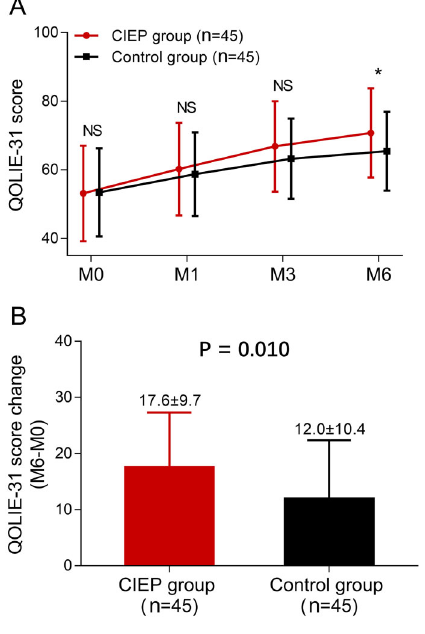
Figure 4. Effect of the caregiver intensive education program (CIEP) on the quality of life (QOL) of patients with drug-resistant temporal lobe epilepsy and mesial temporal sclerosis (TLE-MTS) who underwent cortico-amygdalohippocampectomy (CAH). A , QOLIE-31 score at month (M)0, M1, M3, and M6 in the CIEP group and control group; B , QOLIE-31 score change (M6-M0) in the two groups. Data are reported as means ± SD. P o 0.05 was considered statistically signi fi cant by Student ’ s t -test. NS: not signi fi cant; QOLIE-31: Quality of Life in Epilepsy Inventory-31.